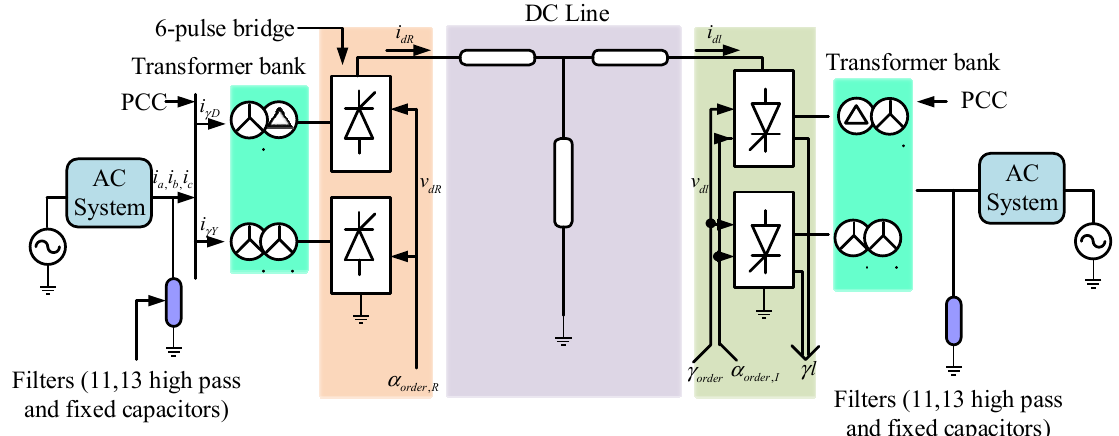
Figure 8. The configuration of a 12-pulse LCC HVDC system.